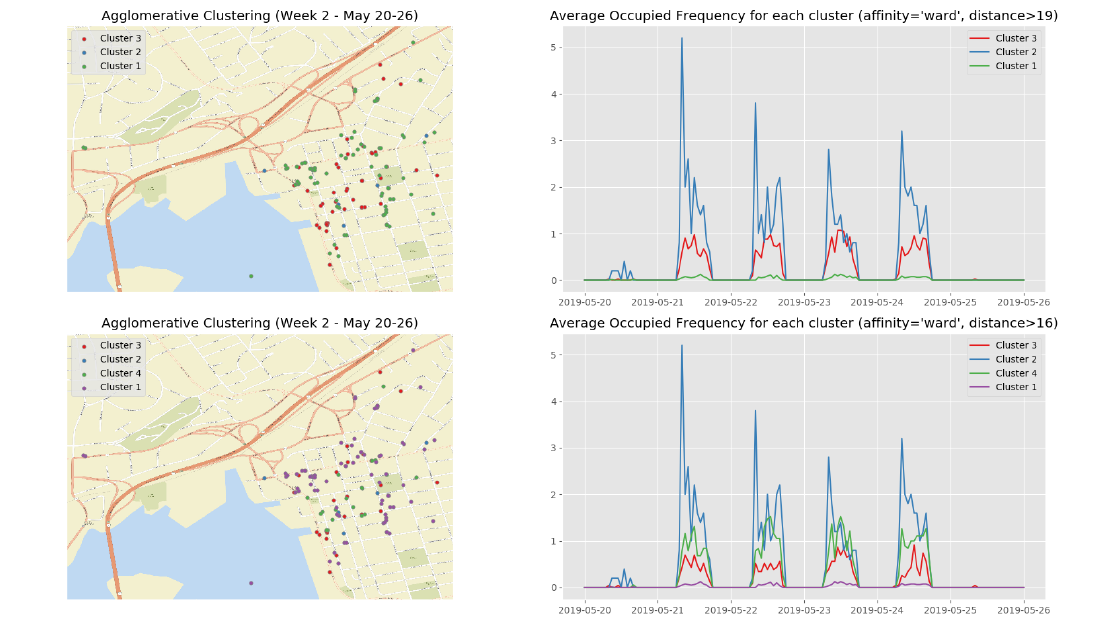
Figure A3. Clustering results for the 2nd